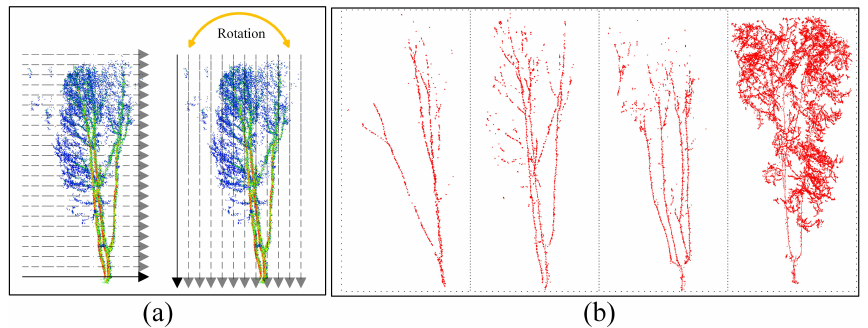
Figure 2. Candidate point extraction. ( a ) Split of input data into slices. ( b ) Examples of candidate point extraction